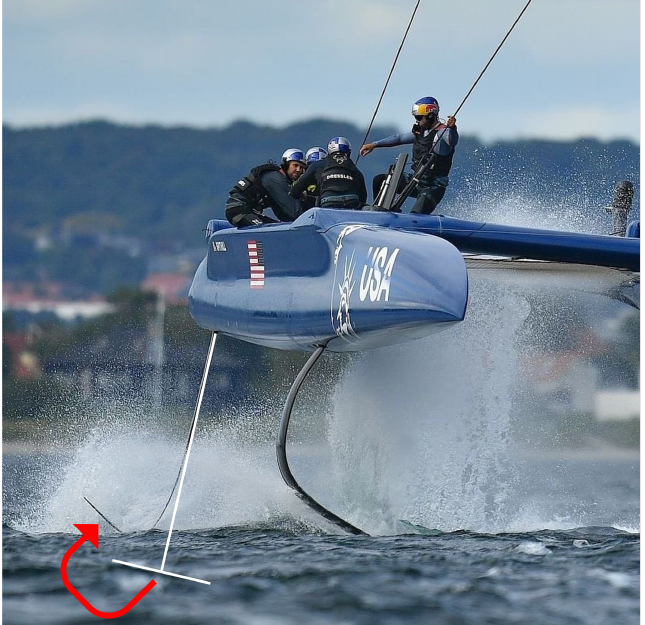
Figure 2. Example of large rudder deflection during sailing load of the Team USA high-performance catamaran from the F50 fleet in a SailGP